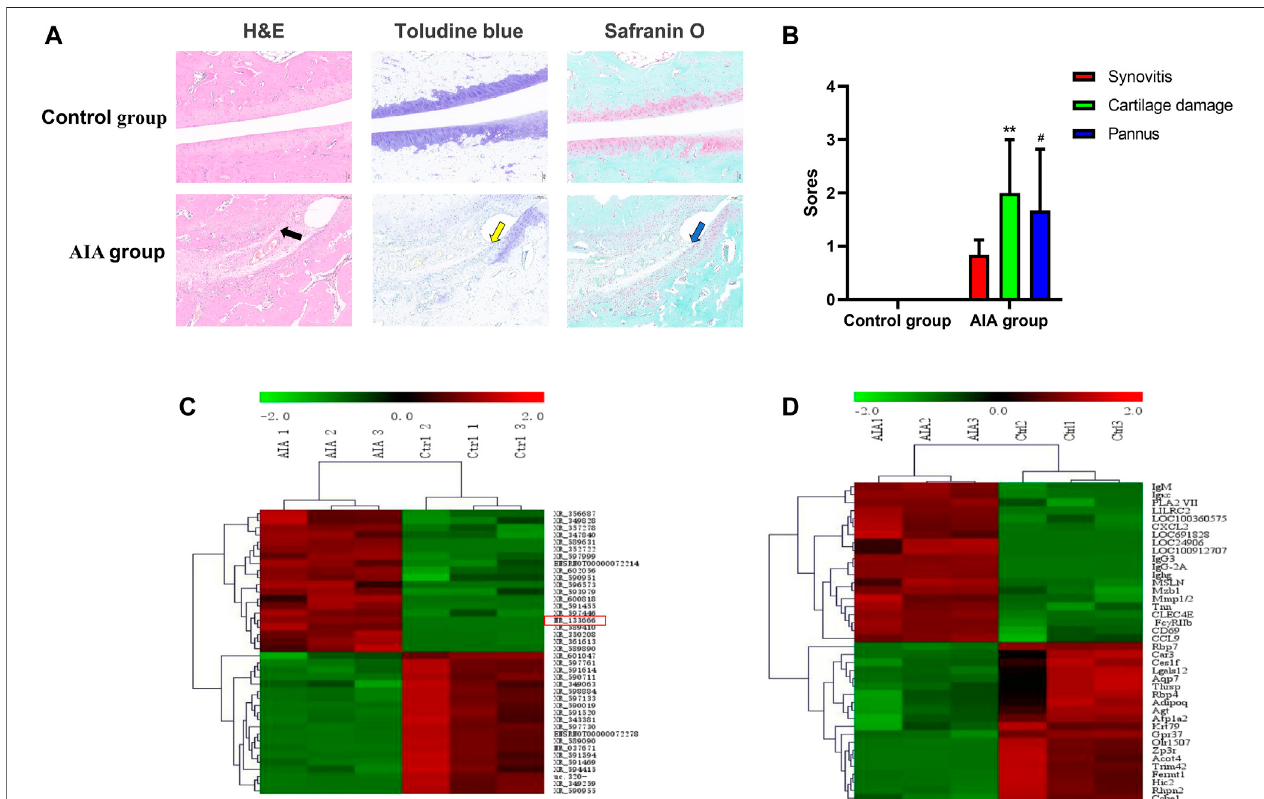
FIGURE 1 | Pathological and morphological changes and the different expression analysis of lncRNA and mRNA in synovial tissue from the control and AIA model group. (A) Compared with the control group, H&E staining of knee joint sections showed severe articular cartilage damage, adhesion and lymphocyte in fi ltration in the AIA group (black arrow); toluidine blue and safranin O staining showed that a large area of staining was lost and a large amount of chondrocytes was lost (yellow arrow), and bone damage was serious (blue arrow). (B) The quantitative analysis showed severe synovitis, cartilage damage and pannus of AIA model group ( n = 3). Compared with controls, ** p < 0.01, # p < 0.05. (C) Heat maps show the top 20 signi fi cantly upregulated and downregulated lncRNAs. lncRNA NR-133666 was enhanced in the AIA group. (D) Heat maps show the top 20 signi fi cant upregulated and downregulated mRNAs.